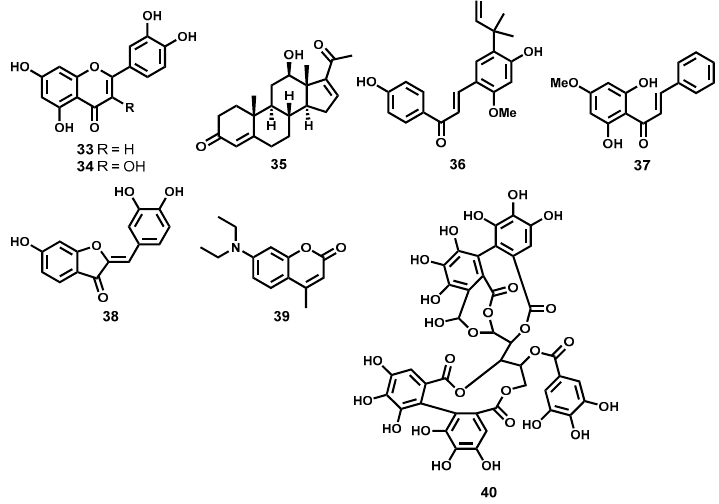
Figure 7. Antileishmanial flavonoids, sterols, chalcones, coumarins, tannins and